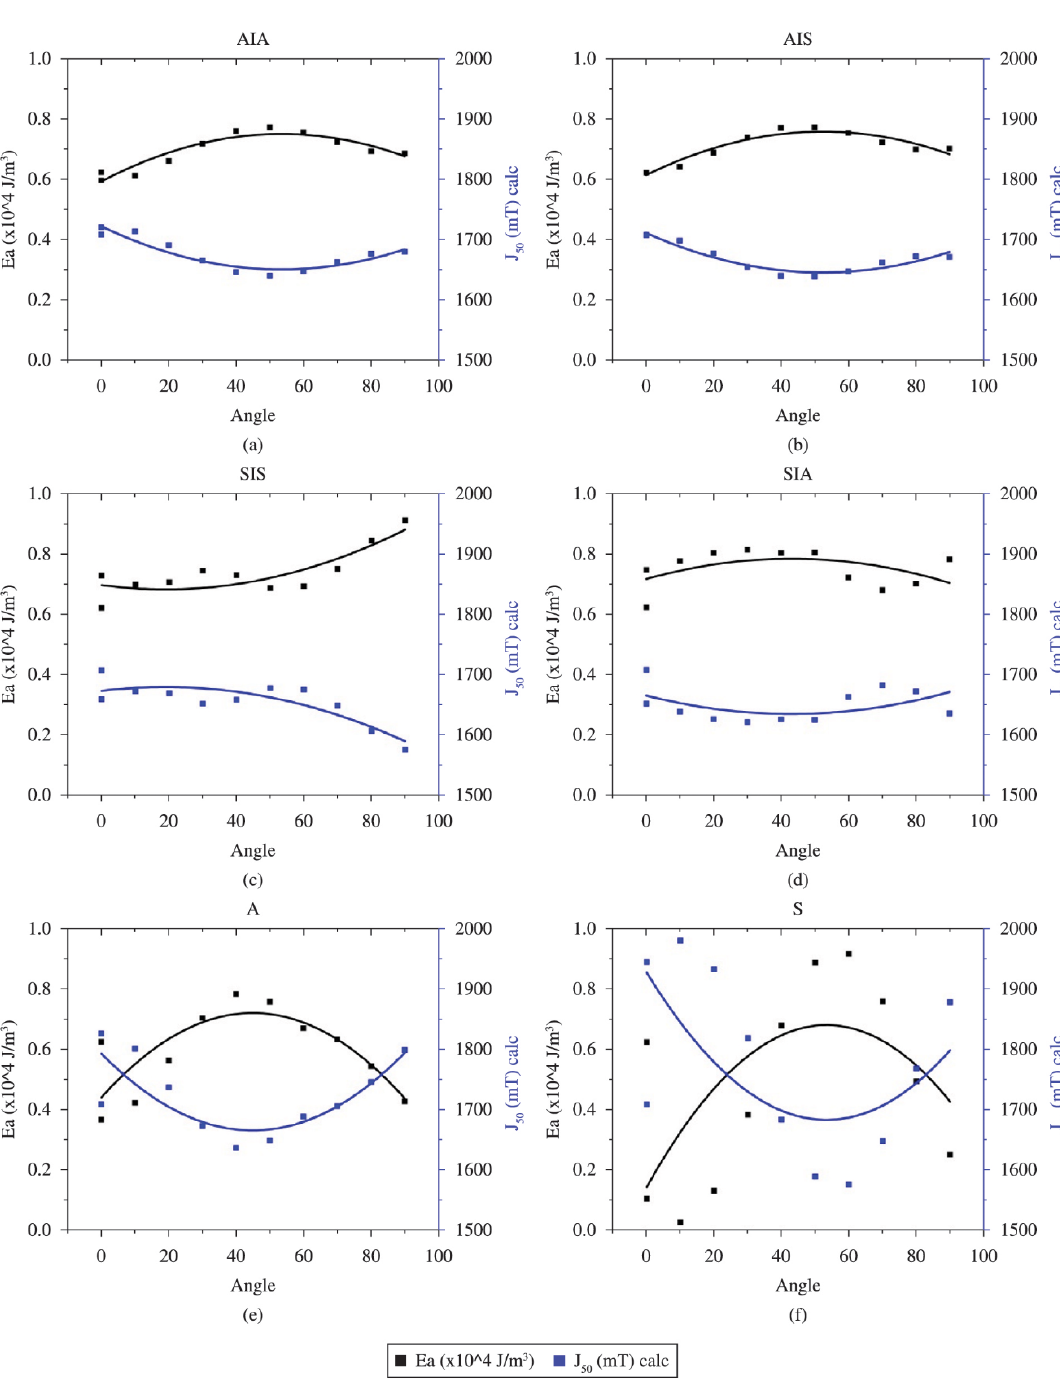
Figure 4. J as a function of the rolling 50